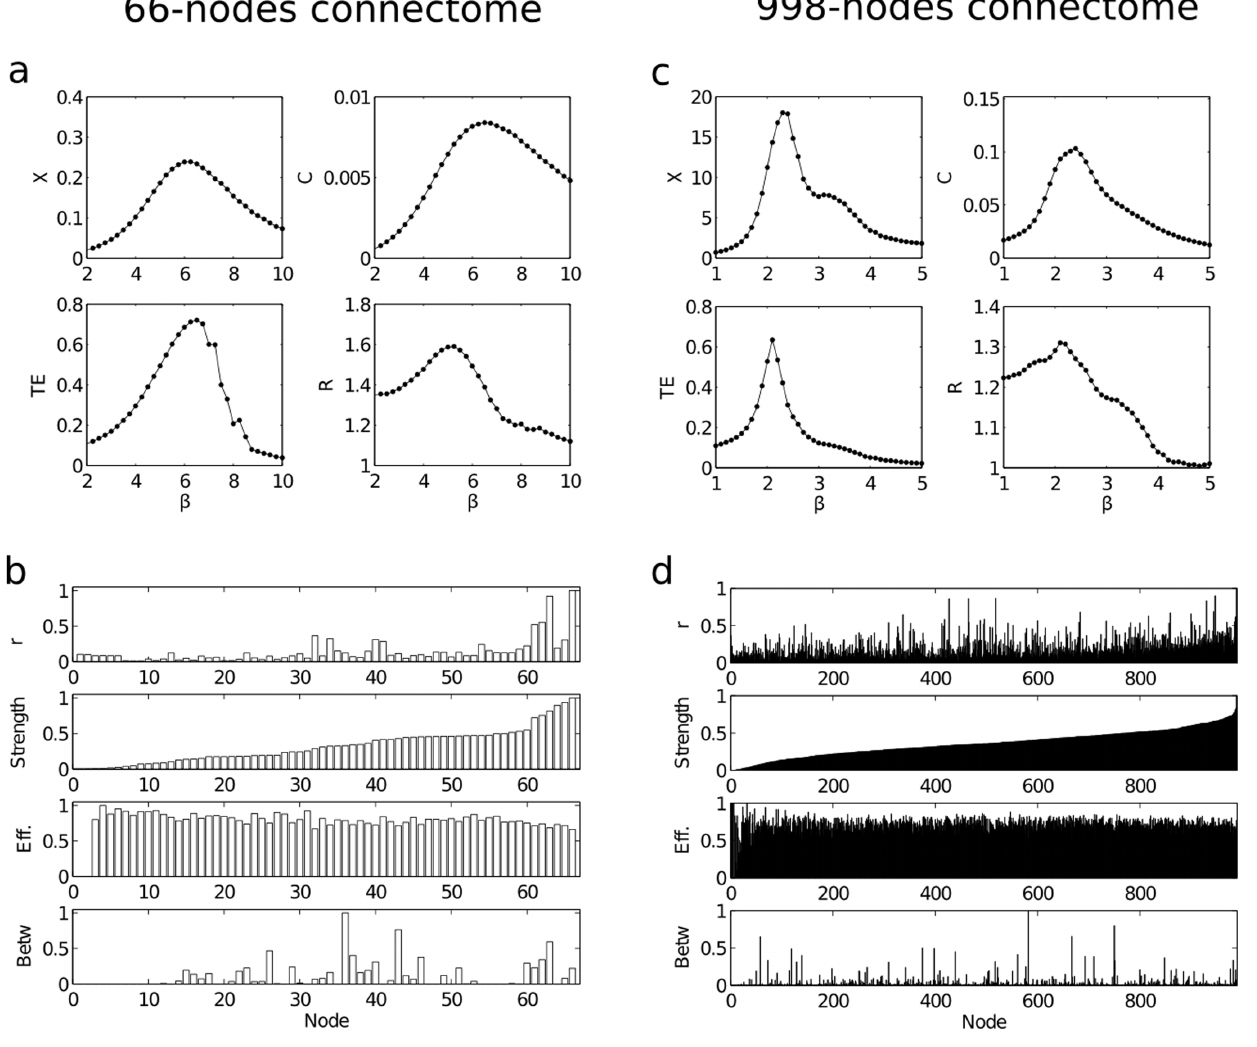
Figure 1. Ising model on the different brain connectomes. a,b: 66-nodes connectome. c,d: 998-nodes connectome. a: The following quantities are depicted versus the inverse temperature b : the susceptibility x ; the heat capacity C; the total transfer entropy TE, i.e. the sum of all the information flows in all network pairs; R the ratio between the standard deviations of outgoing and incoming information flows). b: The distribution of the node- measure r in comparison with different topological measures such as the nodes strength (the sum of the connections weights to each node in the connectivity matrix A ij ), the efficiency and the nodes betweenness. The values of r have been normalized to the interval [0,1]. Nodes have been ordered according to increasing strength. Note that r is not fully explained by the strength as there are nodes with intermediate strength but with high r. Here the value of the temperature corresponds to the one that maximized R but similar patterns are obtained varying b . c: same as in panel a but for the 998-nodes connectome. d: same as in panel c but for the 998-nodes